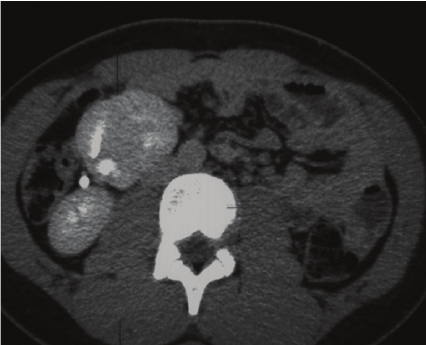
Figure 1: 16-year-old adolescent male with left-to-right crossed renal ectopia. Axial CT scan with intravenous contrast-delayed phase demonstrates two normal enhancing kidneys on the right.